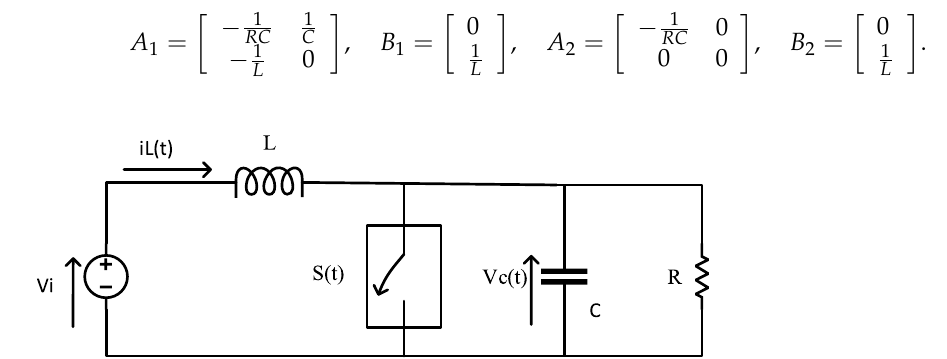
Figure 2. Boost converter